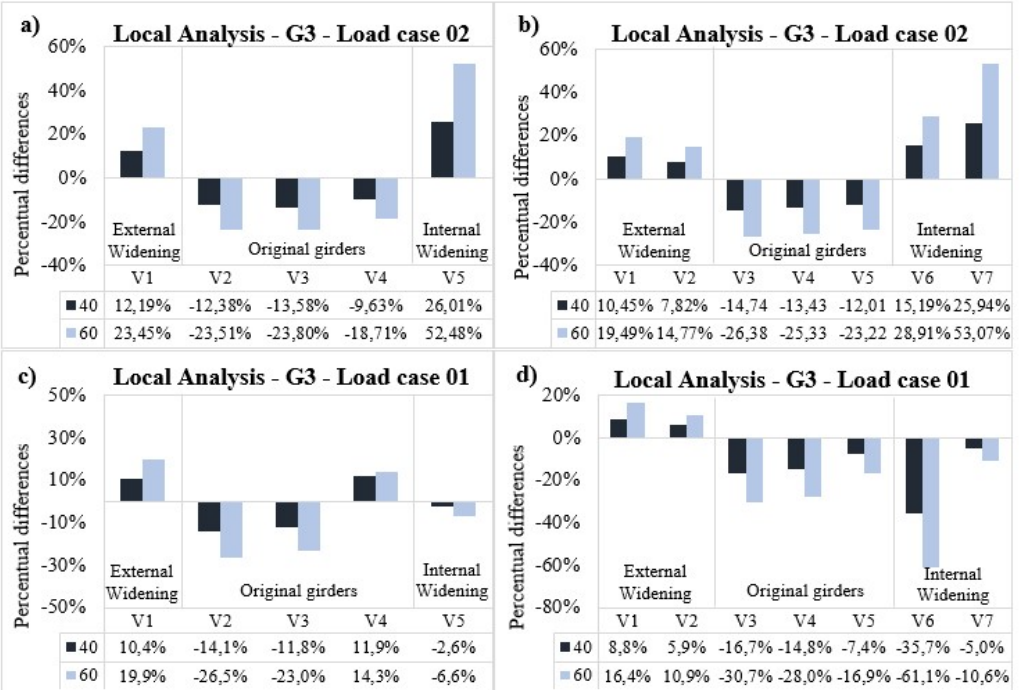
Figure 12. Local analysis of the BMDF's for models with 40 and 60 MPa widening, compared to the models with uniform stiffness.: (a) 5L-G3 (Load case 02); (b) 7L-G3 (Load case 02); (c) 5L-G3 (Load case 01); (d) 7L-G3 (Load case